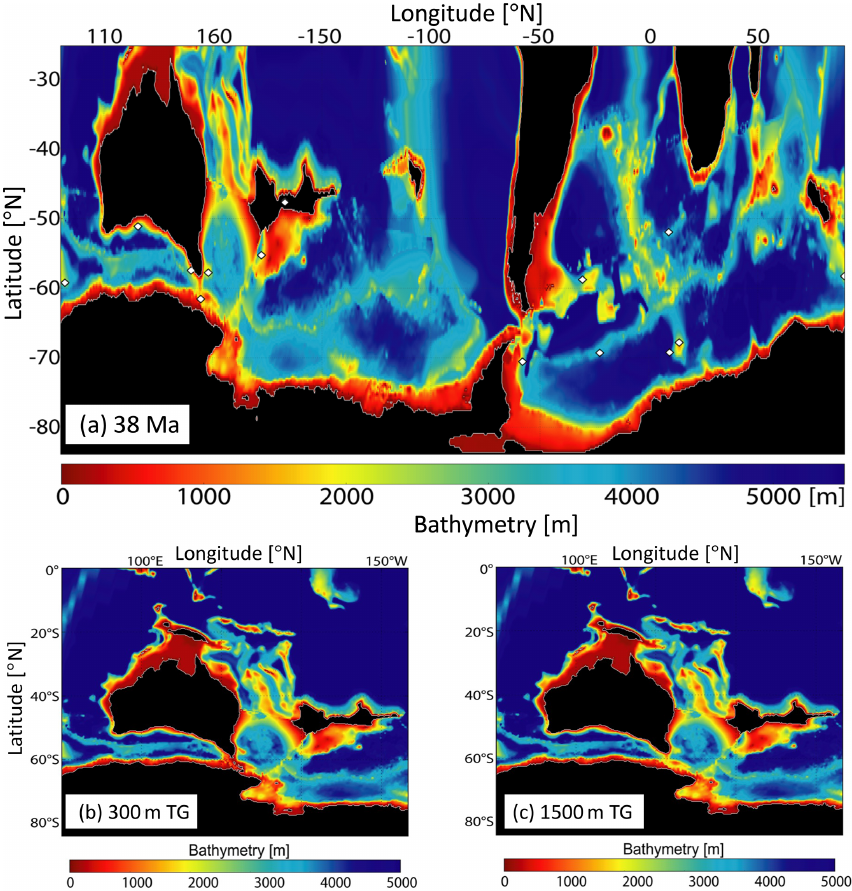
Figure D1. (a) High-resolution (0.25 ◦ ) reconstructed bathymetry of the late Eocene (38Ma) Southern Ocean. (b) Bathymetry of the 300m TG. (c) Bathymetry of the 1500m